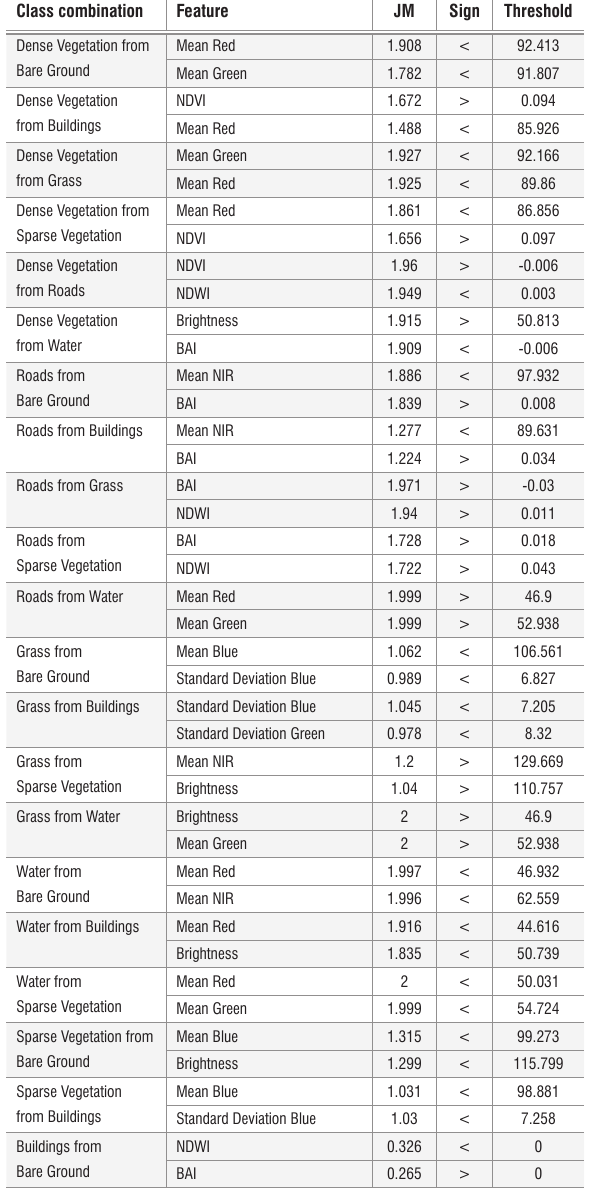
Table 4: Separability of land-use/land-cover classes using spectral